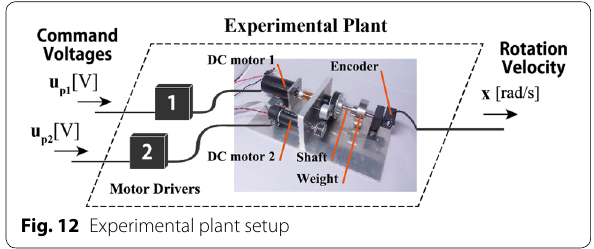
Fig. 12 Experimental plant setup